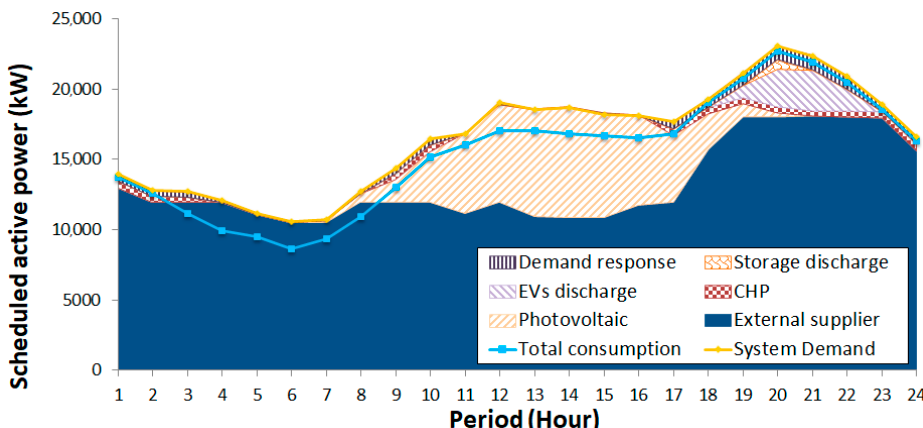
Figure 8. Energy resource scheduling of min(GHG).